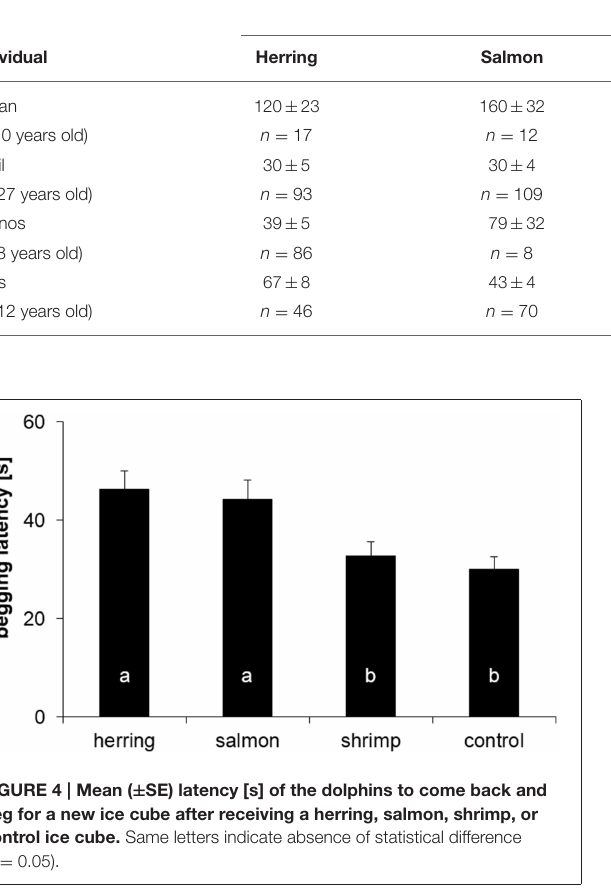
TABLE 3 | Average latency to beg for another ice cube (in seconds) and number of given ice cubes for the differently flavored stimuli and for each individual dolphin (mean ± SE ; n ). Individual Herring